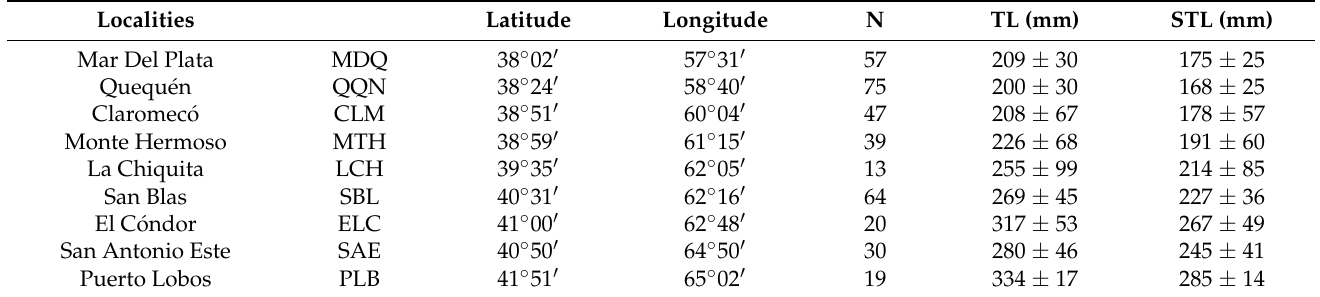
Table 1. Sampling locations ordered from north to south. Mean values of Total Length (TL) and Standard Length (STL) ± Standard Deviation. N: sample number.